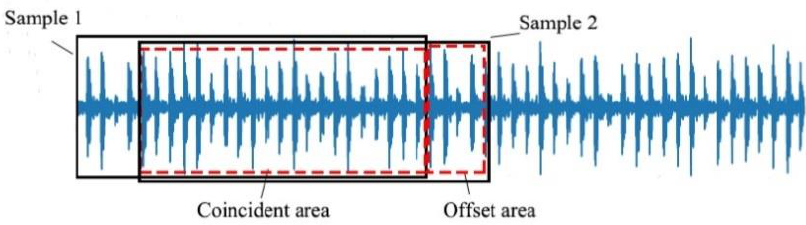
Figure 4. Schematic diagram of resampling sample extraction.